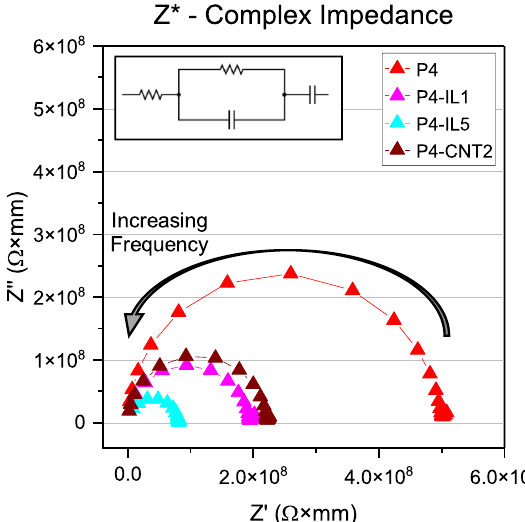
Figure 2. Argand plot of complex impedance of PVC gels with fillers.